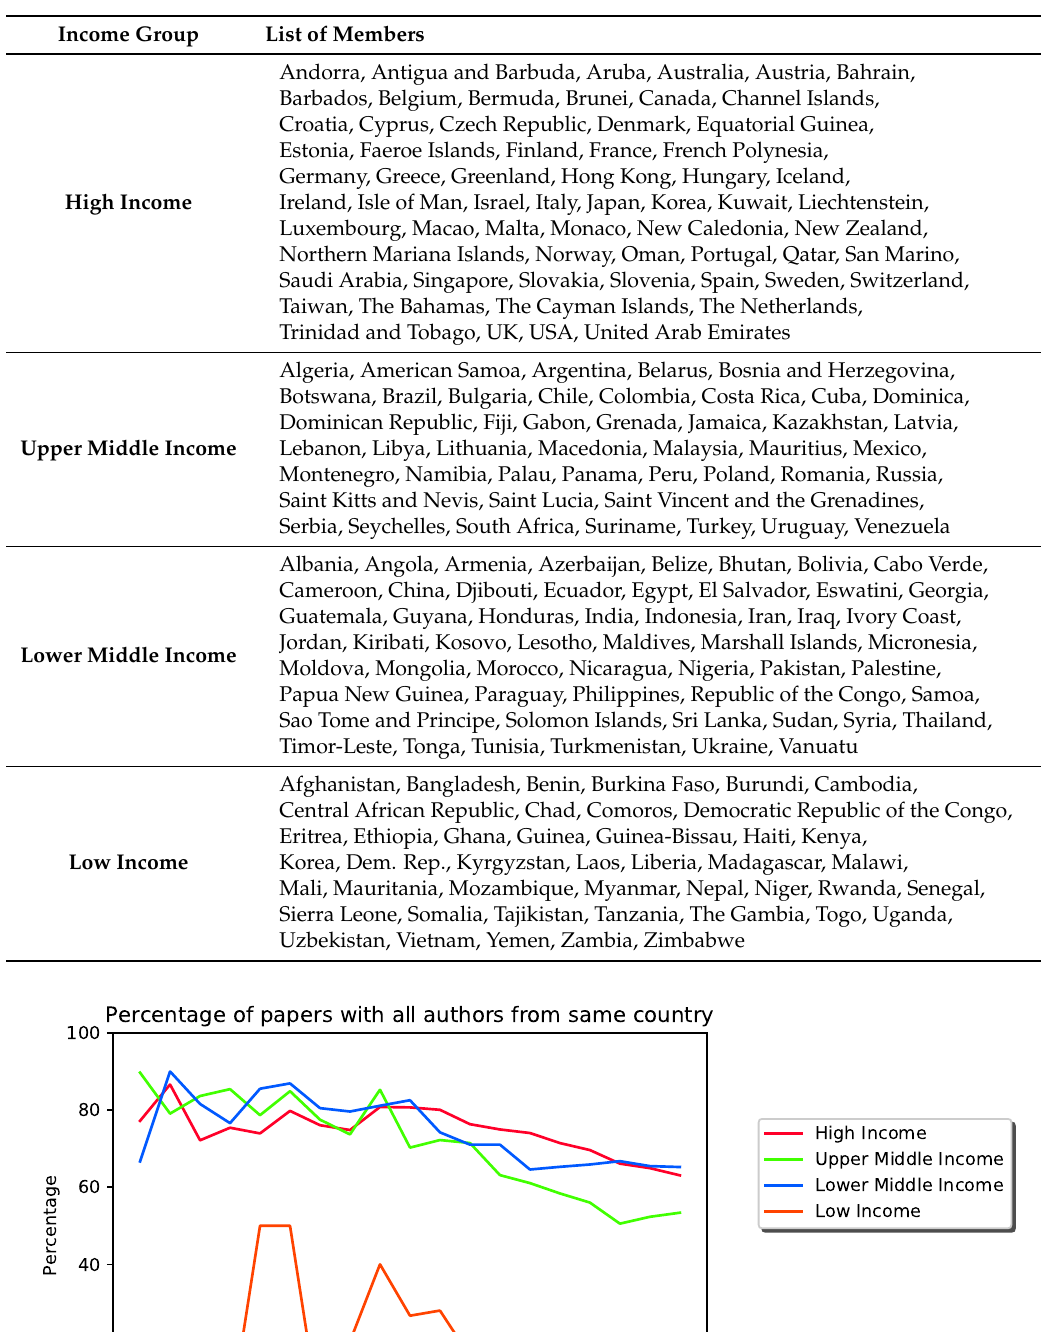
Table 3. Income Group Membership Table.